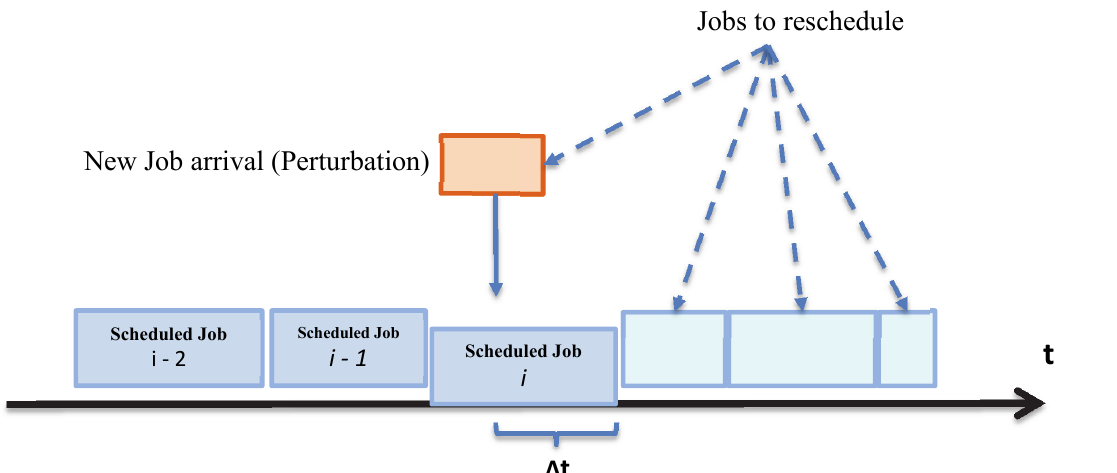
Fig. 2. New job arrival triggers an identification of jobs and parameters for rescheduling Mutation Probability ( P m ). The mutation probability is also a parameter that differs depending on the optimal mechanism. While for the GA and the AGA1 , the mutation rate is 0.01, for the other two the rate includes an inner dynamism. For the AGA2 , the P m changes linearly starting from 0.01 until it is finished when Δ t time has passed with 0.1 (Pan et al., 2011). Certainly, this parameter